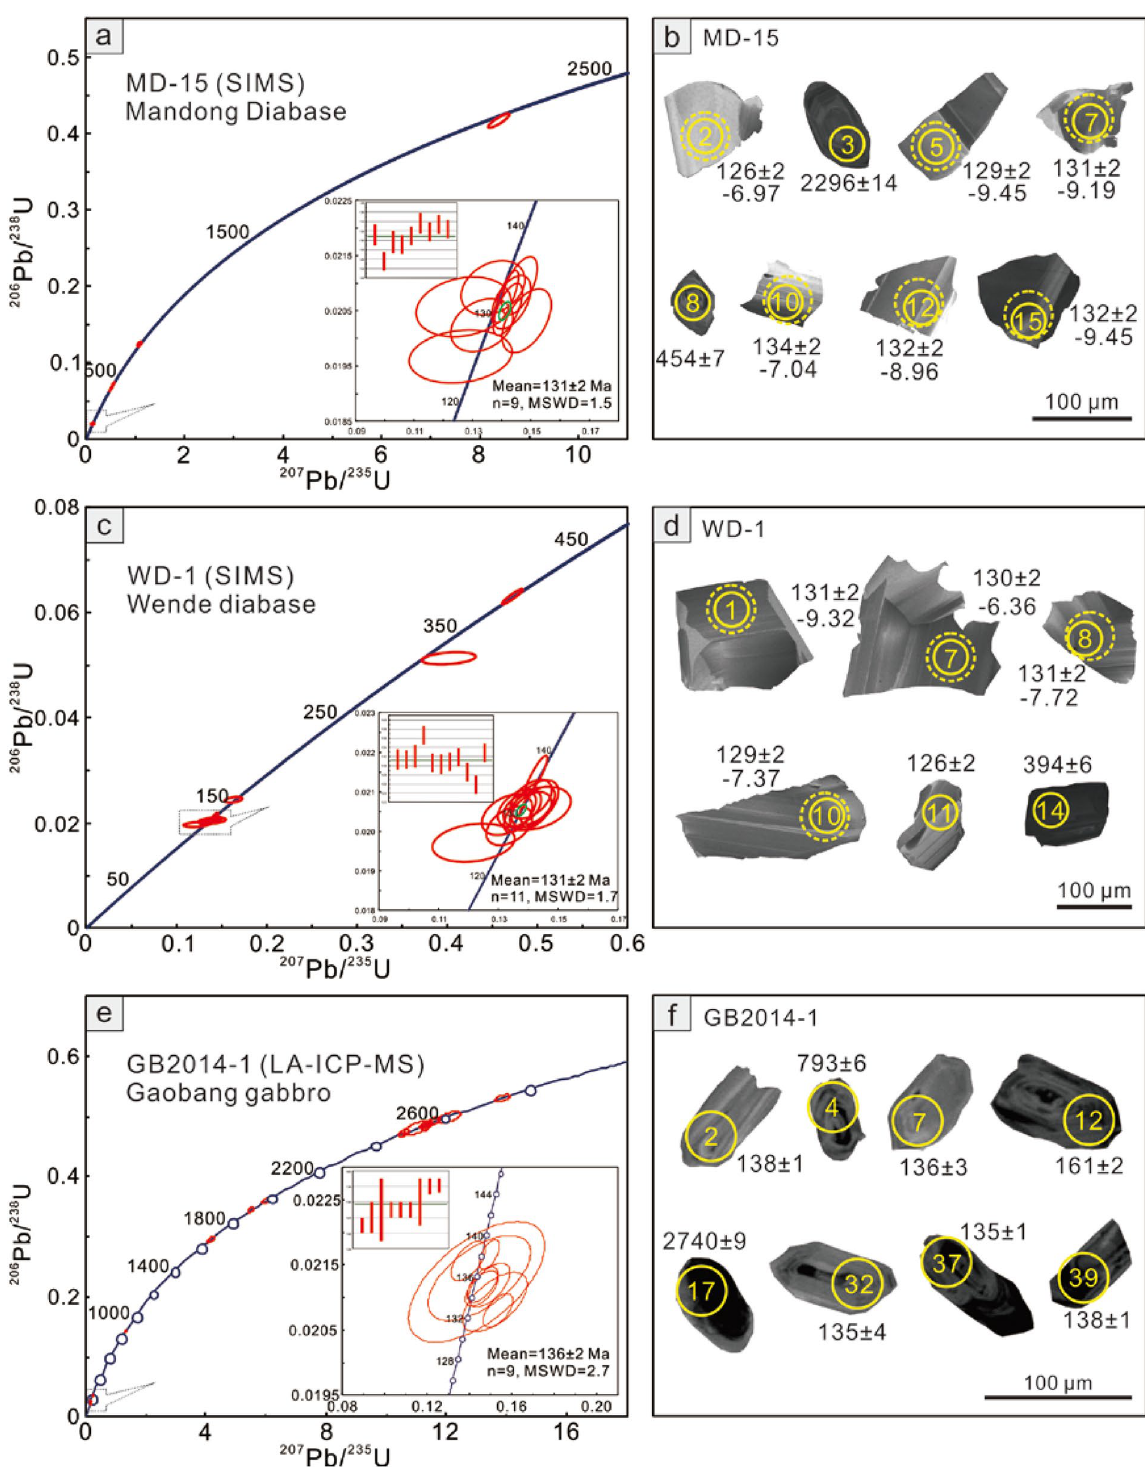
Figure 2. SIMS and LA-ICP-MS zircon U–Pb concordia diagrams for the studied mafic rocks ( a , c , e ) and cathodoluminescence (CL) images of the representative zircon grains for the studied mafic rocks ( b , d , f ). Solid circles represent the laser spots for U–Pb analysis, dashed spots for Hf isotope